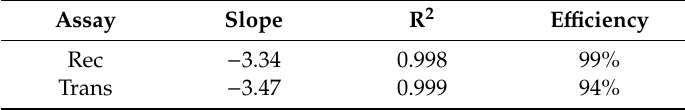
Table 2. Analytical performance of the duplex real-time PCR method. Assay